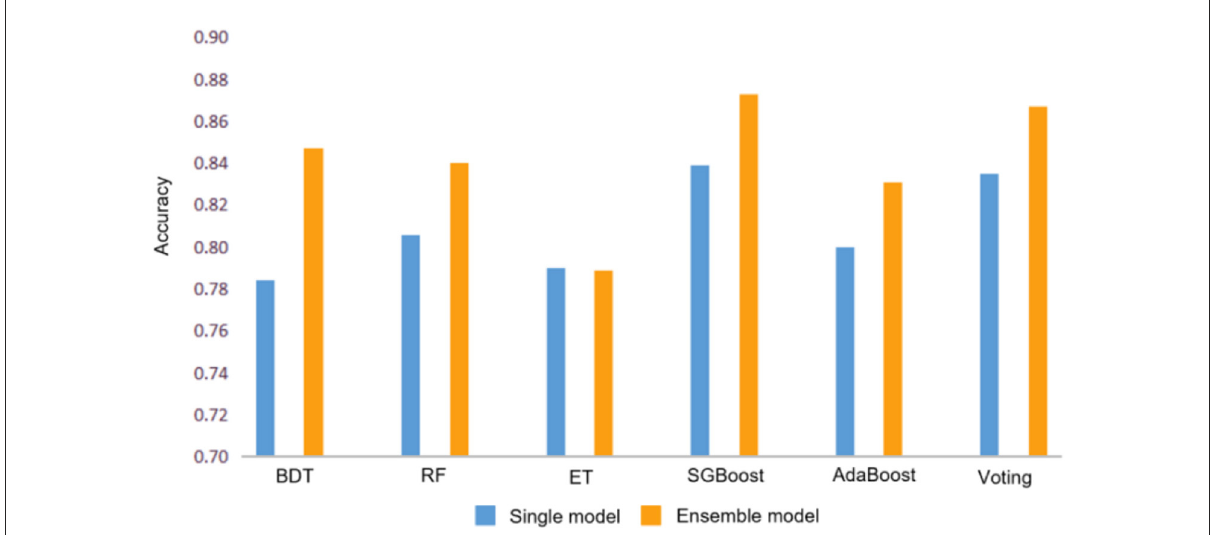
FIGURE4 Accuracy comparison between single model and ensemble model. Where BDT, RF, and ET represent Bagged Decision Tree, Random Forest and Extra Tree